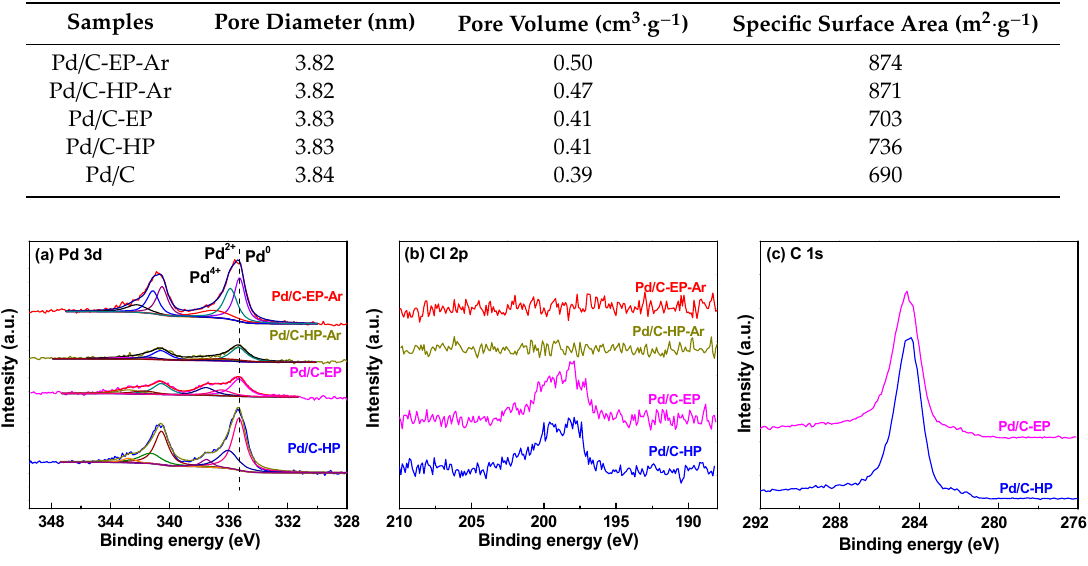
Figure 5. X-ray photoelectron spectroscopy (XPS) spectra of ( a ) Pd 3d and ( b ) Cl 2p in Pd/C-EP-Ar, Pd/C-HP-Ar, Pd/C-EP and Pd/C-HP, as well as ( c ) C1s XPS spectra in Pd/C-EP and Pd/C-HP. Table 2. Pd composition and Pd / C atomic ratios in the Pd / C catalytic